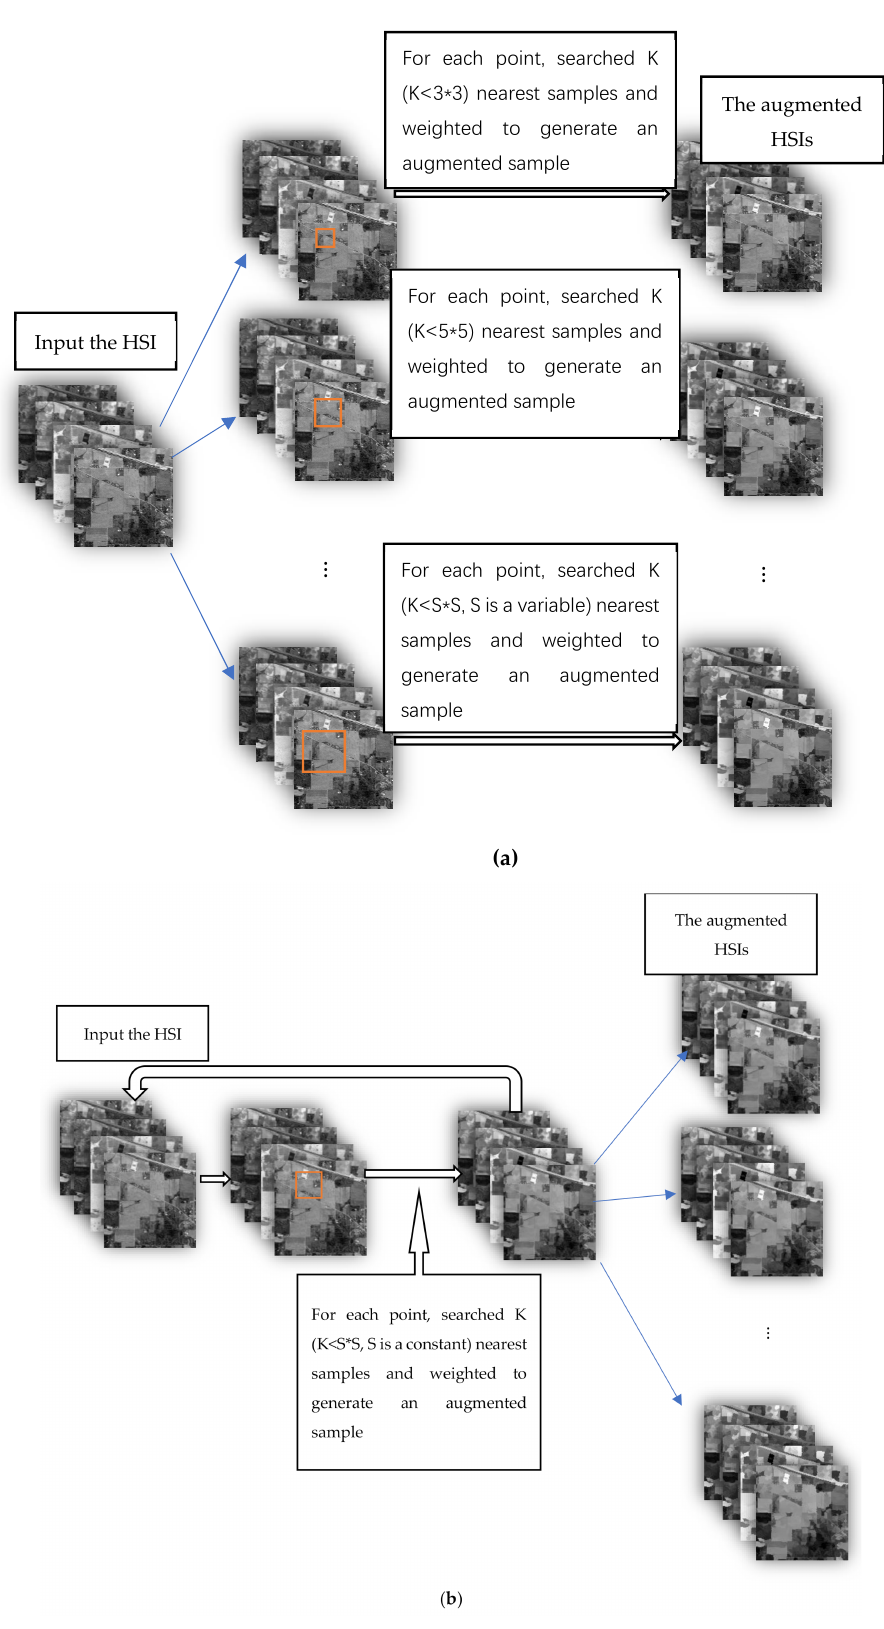
Figure 2. The flow charts of the two data augmentation algorithms: ( a ) the flow chart of the data augmentation algorithm 1; and ( b ) the flow chart of the data augmentation algorithm